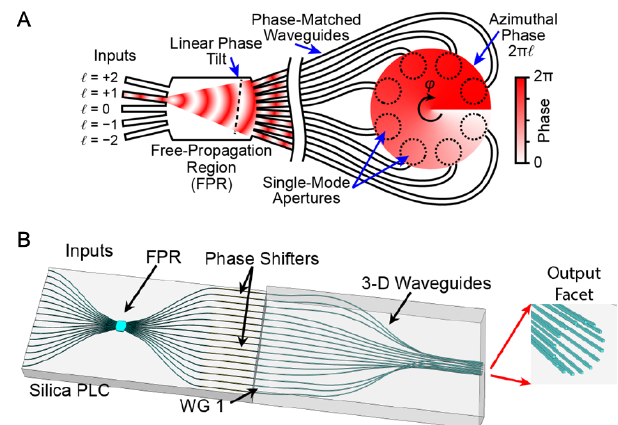
Figure 11: (A) Concept of the hybrid OAM beam multiplexer and demultiplexer for free-space optical communication. A free- propagation region is used to generate a linear phase tilt that is injected into an array of single-mode waveguides. The linear array of single-mode waveguides is rearranged into a circle to act as a synthetic aperture. The amount of phase front tilt determines the order of the OAM beam. (B) Hybrid integration of the OAM beam generator based on a silica planar lightwave circuit (PLC) and an ul- trafast laser inscribed 3D waveguide chip. With permission from